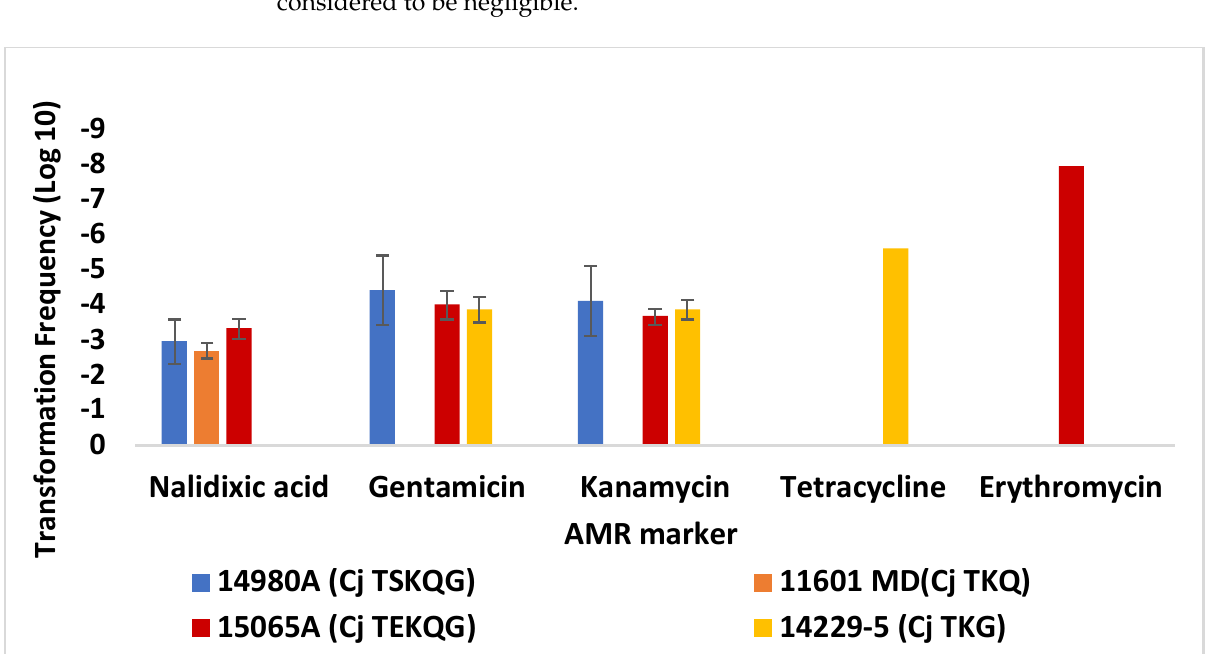
Figure 1. Transformation of C. jejuni SN:CM with DNA from C. jejuni 14980A and C. coli 14983A. Transformation frequencies are averages from two or more independent trials for each recipient strain–donor DNA pair. Letters within each AMR profile indicate resistance to streptomycin (S), gentamicin (G), kanamycin (K), erythromycin (E), or the quinolones nalidixic acid and ciprofloxacin (Q). No erythromycin-resistant transformants were obtained with DNA from C. coli 14983A ( C. je- juni 14980A is susceptible to erythromycin, hence was not used as source of donor DNA), and the transformation frequencies are below the limit of detection (<10 −8 ). The error bar on the column with different resistance phenotypes exhibited the same low values described above for C. jejuni the transformation frequency data for erythromycin resistance was too small to be visible. Transfor- SN:CM, and thus their contribution to the calculations of transformation frequencies was mations were carried out as described in Materials and Methods. considered to be negligible.